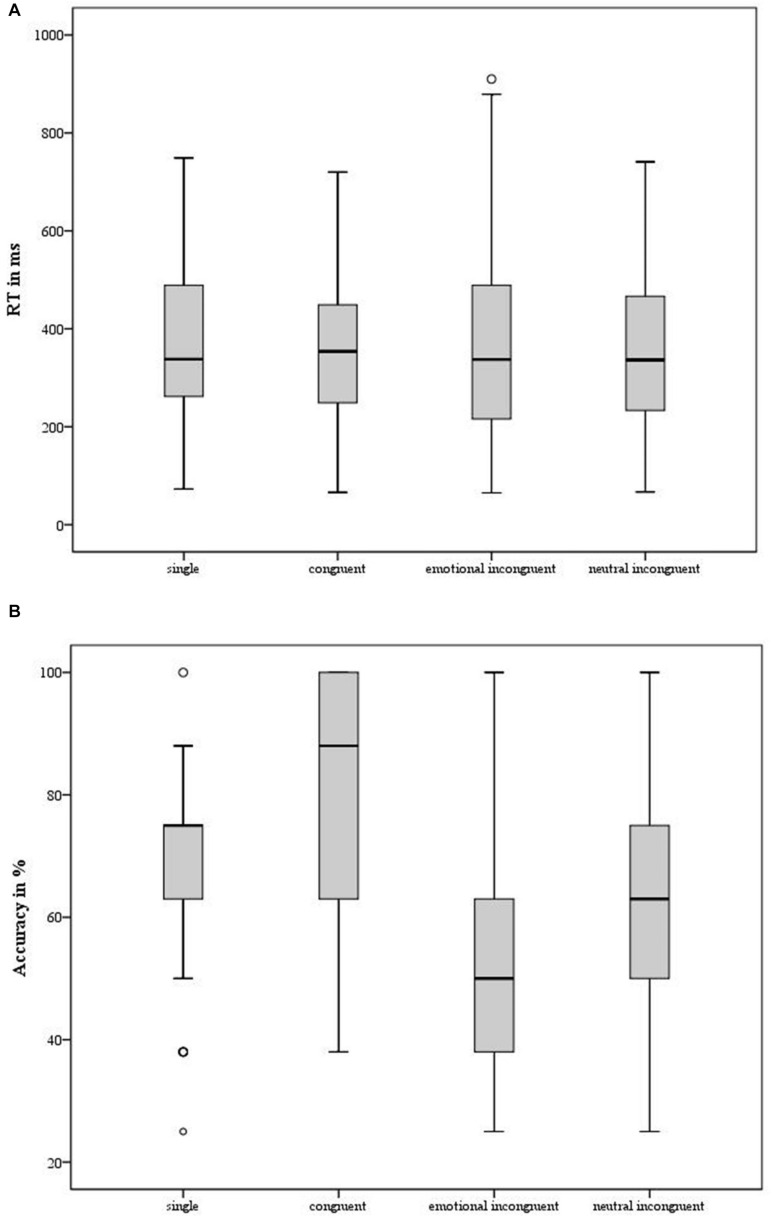
Implicit facial emotion recognition task. (A) For each experimental condition (x-axis: single, congruent, emotional incongruent, neutral incongruent), the mean of Reaction Time expressed in millisecond (y-axis – ms) was reported. The minimum, the lower quartile, the median, the upper quartile, the maximum, and the outliers were shown. According to the main analyses, no difference emerged between the experimental conditions. (B) For each experimental condition (x-axis: single, congruent, emotional incongruent, neutral incongruent), the mean of the level of Accuracy expressed in percentage (y-axis – %) was shown. Again, the minimum, the lower quartile, the median, the upper quartile, the maximum, and the outliers were shown. According to the main analyses, significant differences emerged between conditions, mirroring the redundant target effect.